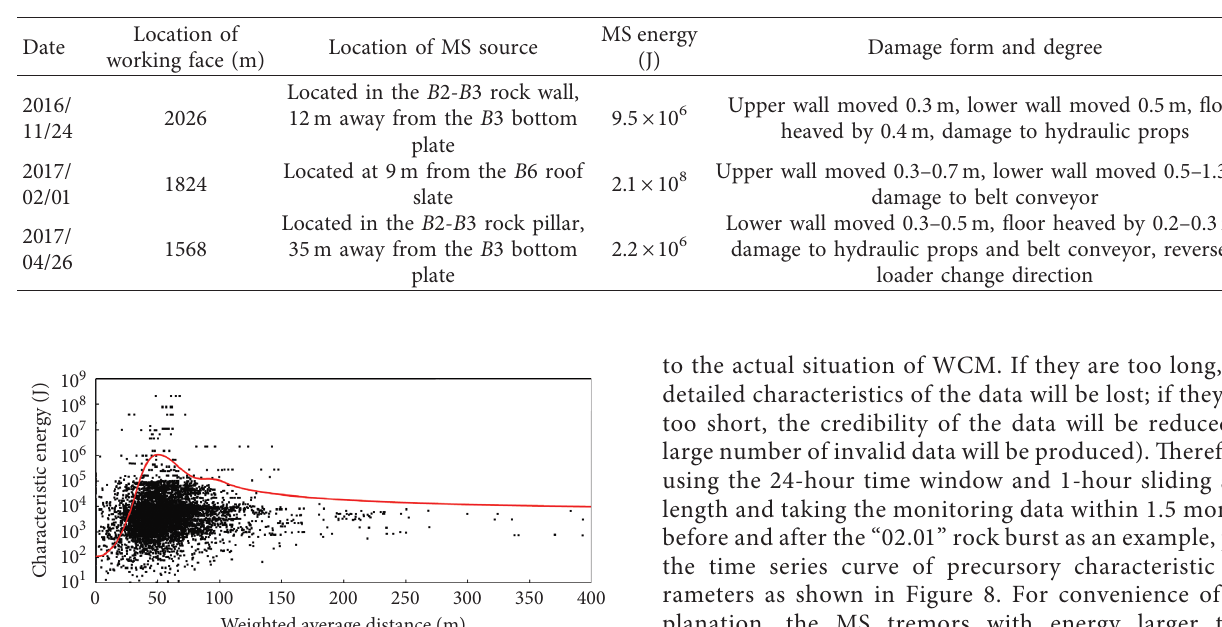
Table 3: On-site rock burst manifestation records.